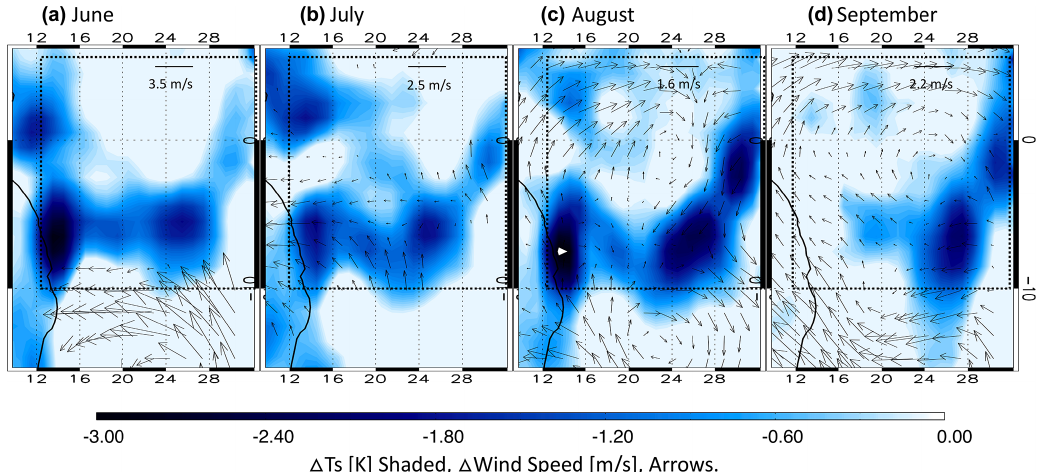
Figure 3. Map of differences in 2m skin temperature ( δT s ; shaded contours) from AIRS and 650hPa δ wind (arrows) from ERA-Interim between (a) 30th–36th pentads (June), (b) 36th–42nd pentads (July), (c) 42nd–48th pentads (August), and (d) 48–54th pentads (September) between 3 early-onset years (2007, 2011, and 2012) and 3 late-onset years (2003, 2006, and 2010). Only the easterly winds are shown in (a) and (b) to show the location of